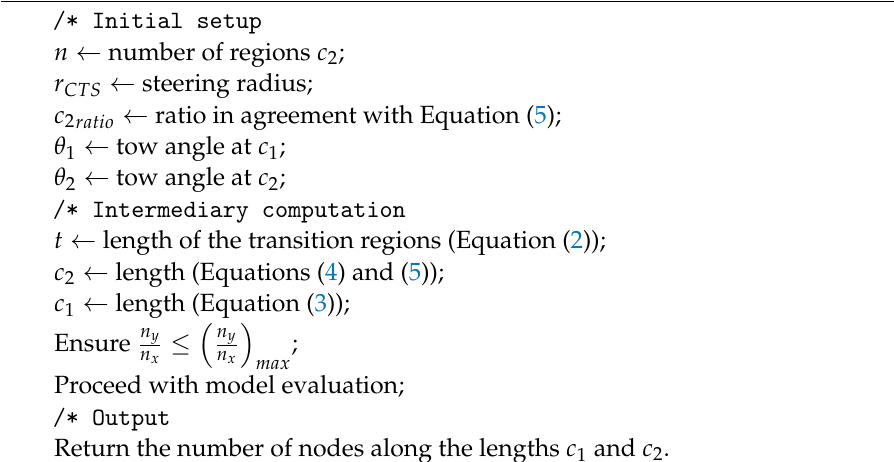
Algorithm 1: The modeling